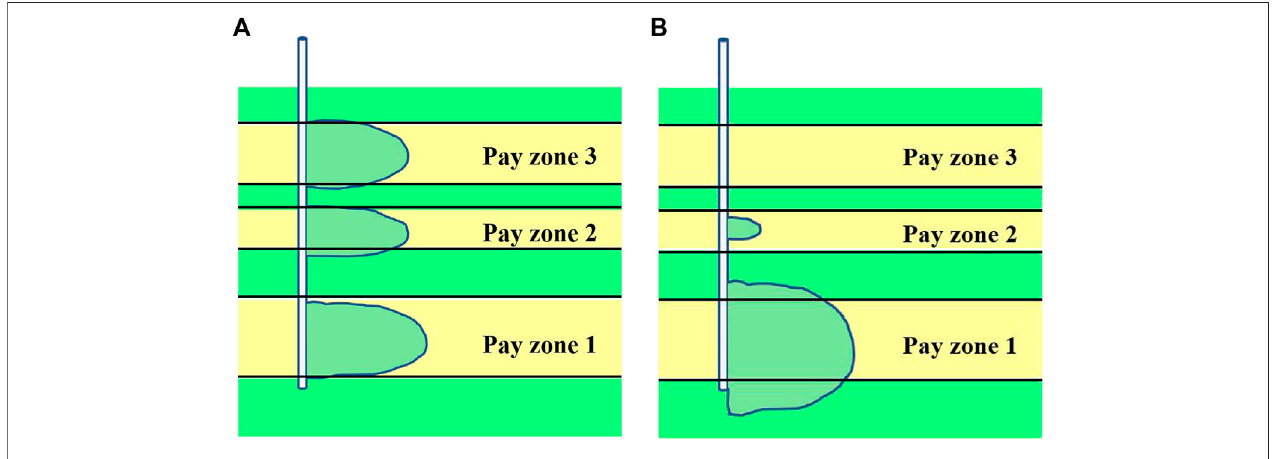
FIGURE 1 | Schematic diagram of multiple zone stimulation in vertical wells. (A) What we want; (B) What we